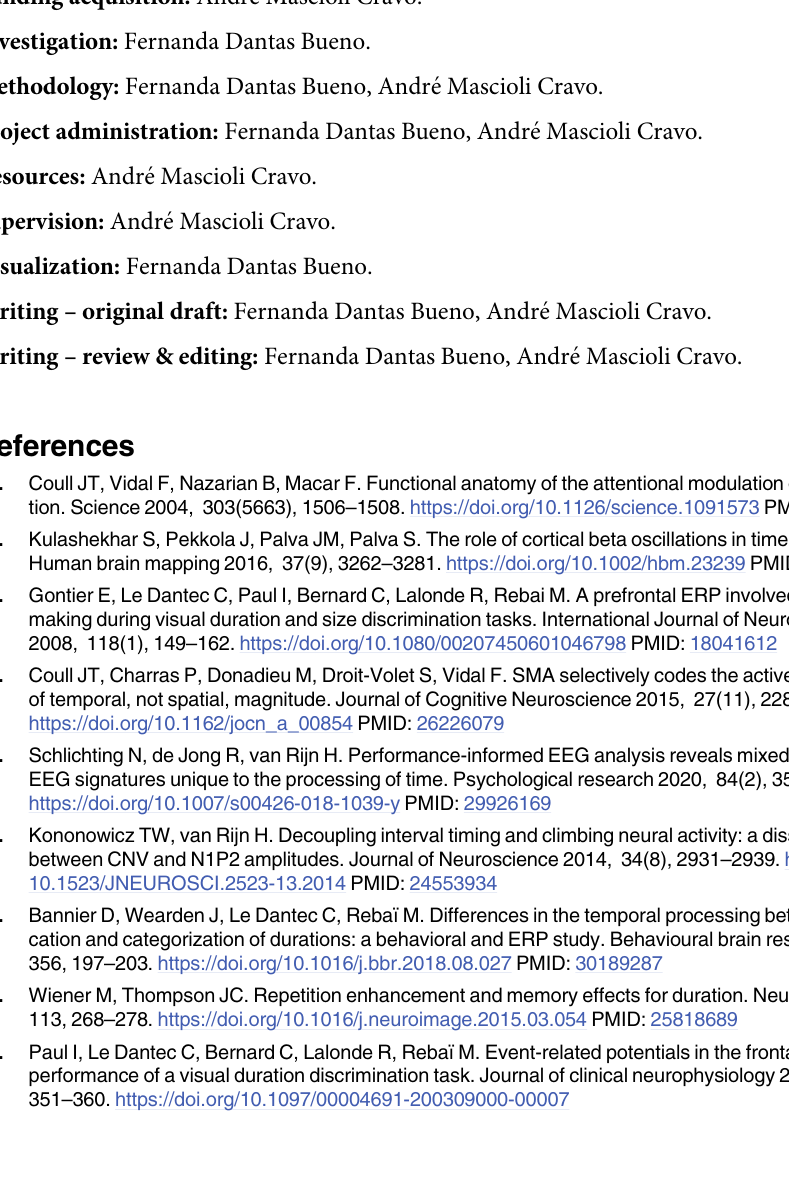
Shaded areas depict the standard error of the